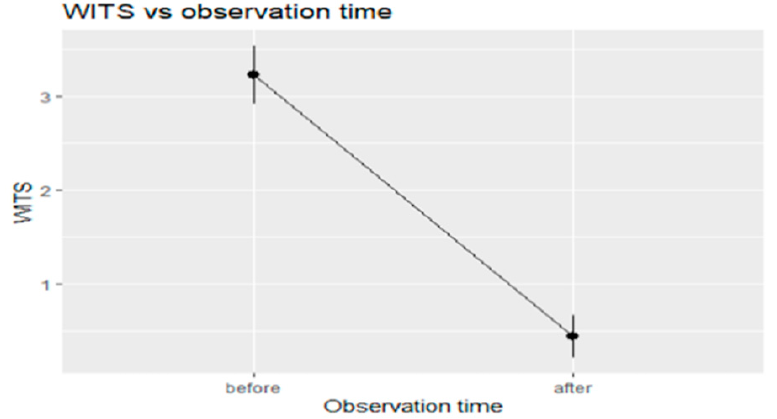
Figure 8. Trend in Wits appraisal over time from T0 to T1.